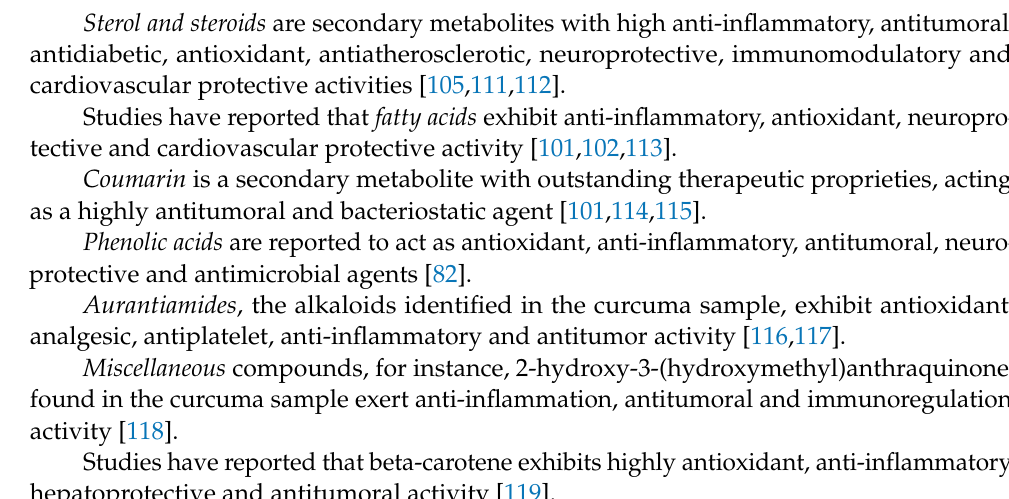
Figure 5. FT-IR spectrum of the curcuma sample and curcuma – AgNP carrier assembly. The FT-IR absorption bands identified in the curcuma sample are presented in Table 4.